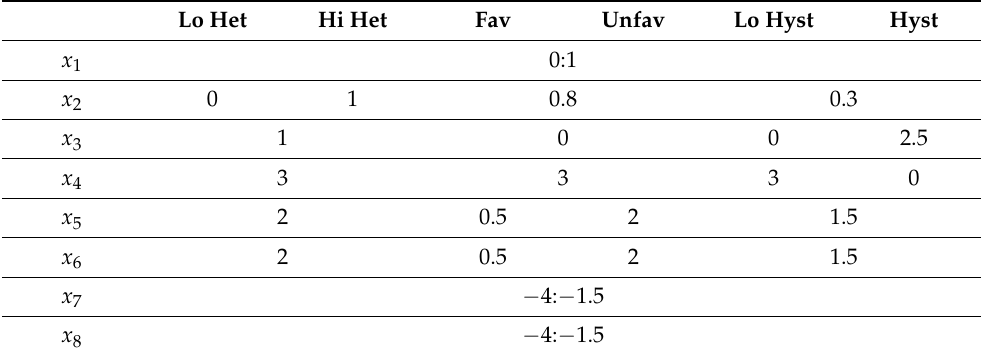
Table 6. Parameter selections for MOD2 with cases demonstrating influence of gravity numbers according to heterogeneity, mobility ratio and